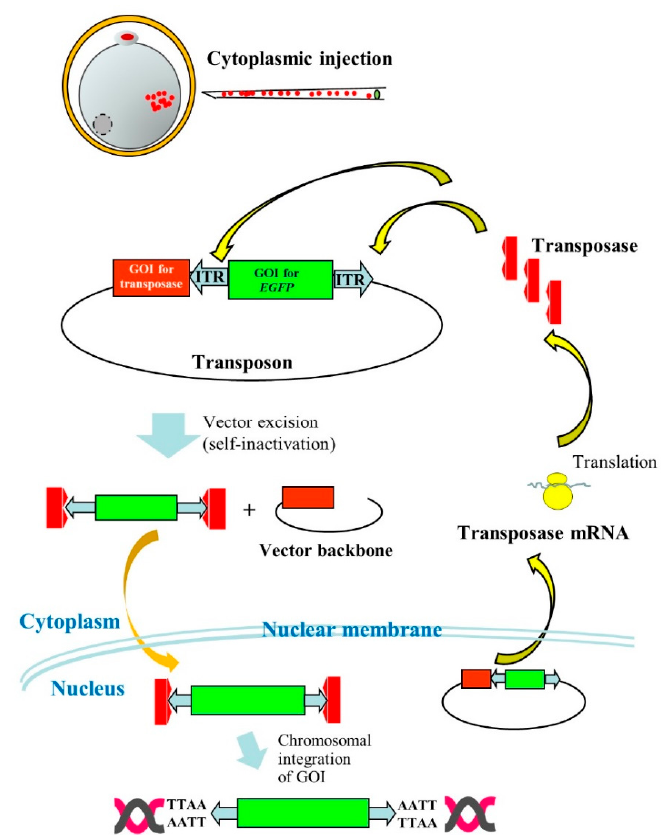
Figure 3. Cytoplasmic injection (CI) of an all-in-one-type piggy Bac (PB) vector pmGENIE-3 into porcine parthenogenetically activated oocytes (parthenotes). Following CI of pmGENIE-3, PB transposase mRNA is expressed from the vector and immediately translated into a protein in the cytoplasm. This protein specifically binds to inverted terminal repeat (ITR) present on pmGENIE-3, leading to vector excision. The resulting complex composed of a gene of interest (GOI) for enhanced green fluorescent protein ( EGFP ) cDNA and PB transposase will be subsequently transferred to the nucleus where chromosomal integration of the GOI will